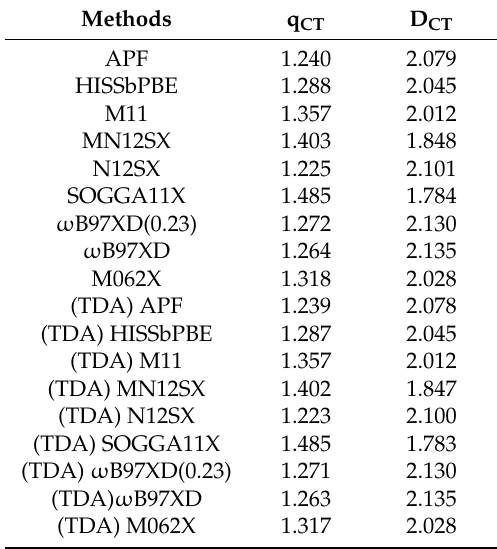
Table 5. The transferred charges q (in e ) and the charge transfer excitation length D CT (in Å) for the CT first singlet charge transfer excited state of the B-TCNE